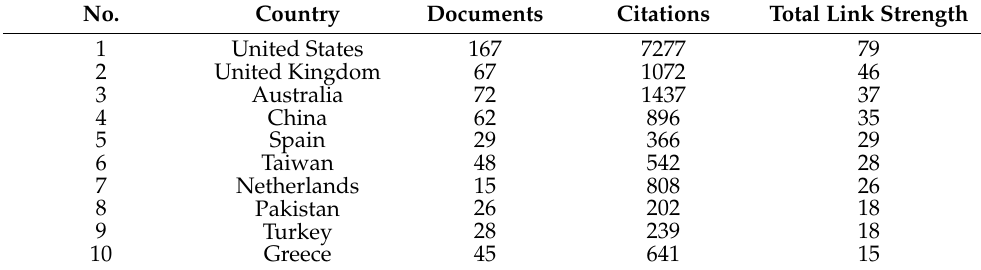
Table 4. Country